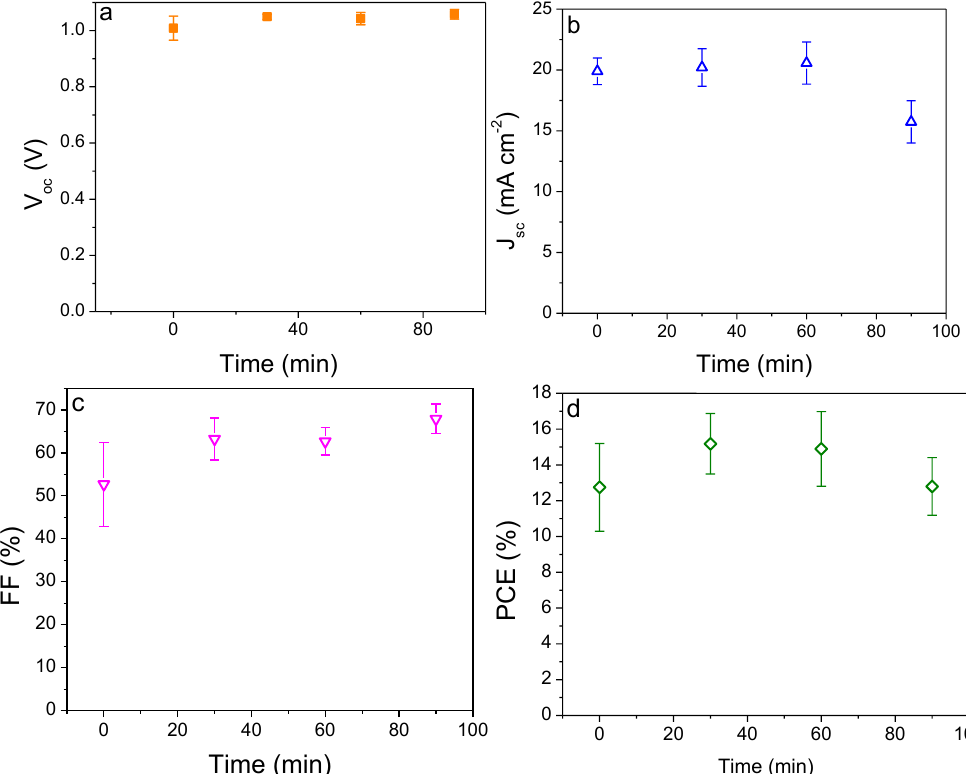
Figure 5. Photovoltaic parameters as a function of electron transport layer TiO 2 treated by 40 mM titanium tetrachloride for different times: ( a ) V oc , ( b ) J sc , ( c ) FF and ( d ) PCE. Table 2. Photovoltaic parameters of the assembled planar PSCs with a typical configuration of FTO/TiO 2 /MAPbI 3 /Spiro-MeOTAD/Ag.